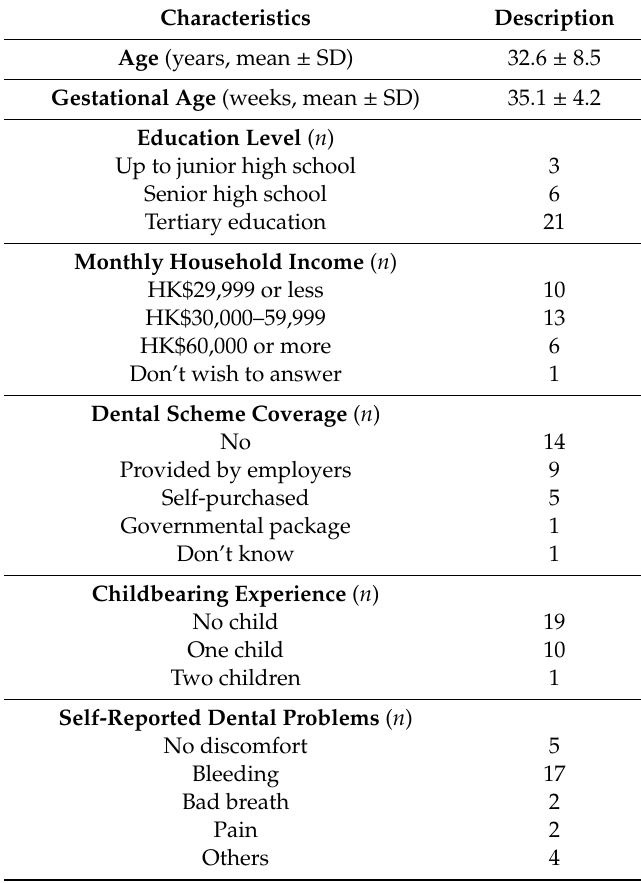
Table 1. Characteristics of participants ( n =